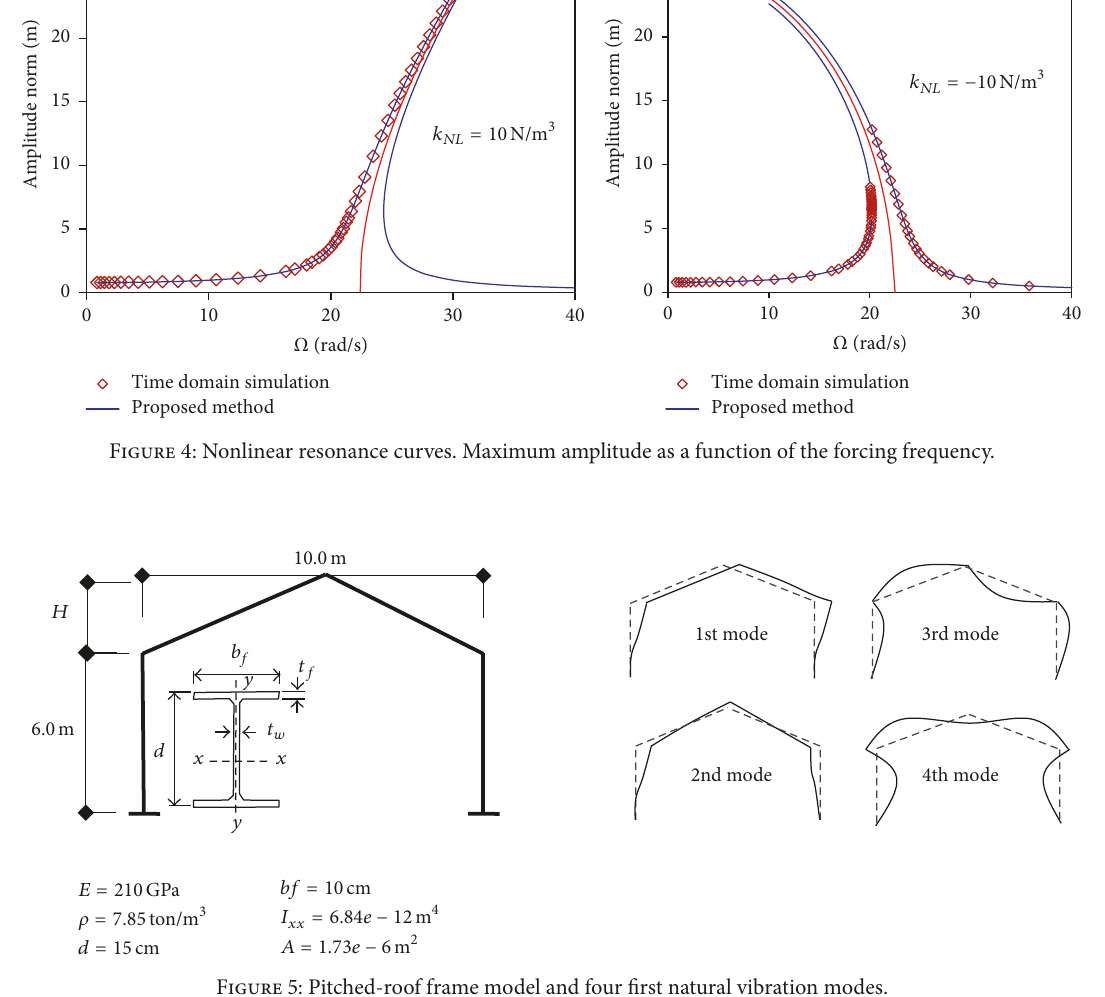
Figure 5: Pitched-roof frame model and four first natural vibration